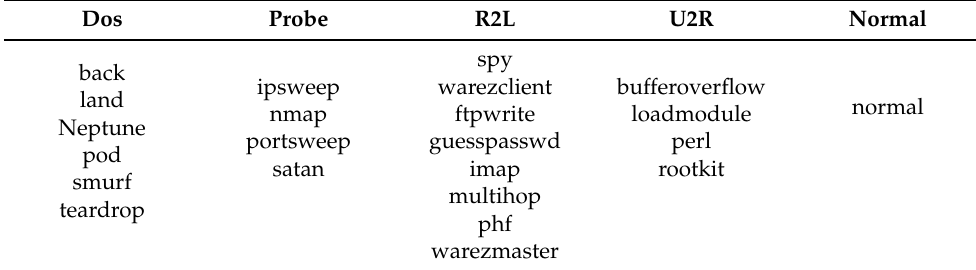
Table 2. The main categories and their contained